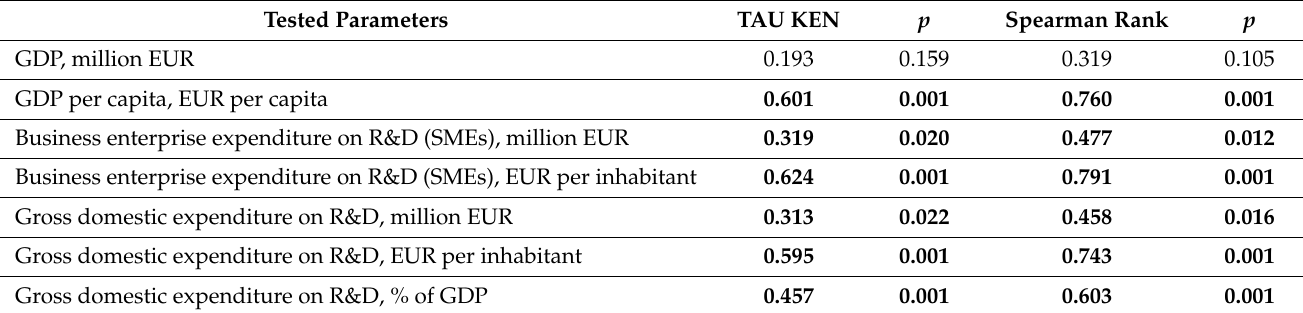
Table 8. The Kendall’s and Spearman’s tau correlation coefficients. Tested Parameters